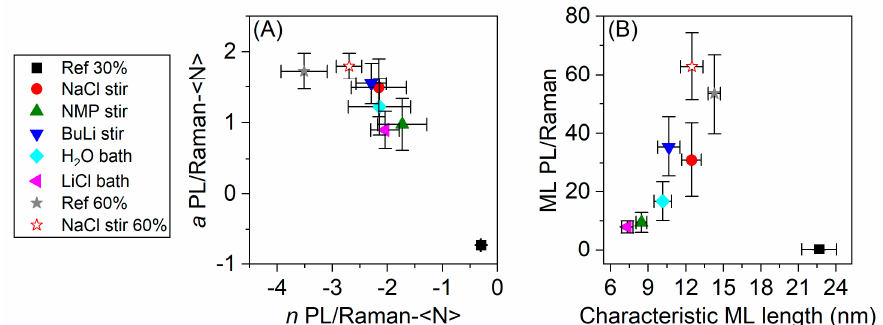
Figure 5. ( A ) Prefactors and exponents extracted from the fits shown in Figure 4. The highest prefactors were found for NaCl stir 60%, closely followed by Ref 60%. The pretreated materials of the 30% series group together. Ref 30% shows the lowest prefactor and smallest value of the exponent. ( B ) ML PL/Raman as a function of the characteristic ML length. The higher the ML length, the higher the ML PL/Raman ratio, with exception of Ref 30%, which shows a negligible ML PL/Raman ratio despite of the highest characteristic ML length, suggesting defective nanosheets.